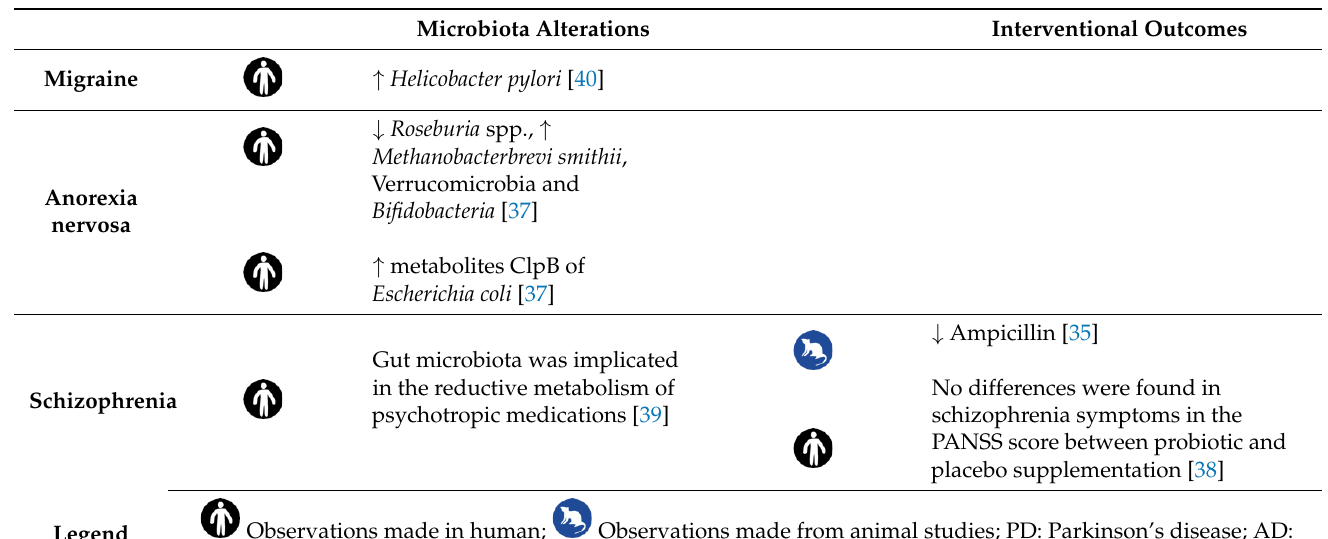
Table 1. Microbiota -based interventions and their effect on the various neuropsychiatric disorders.